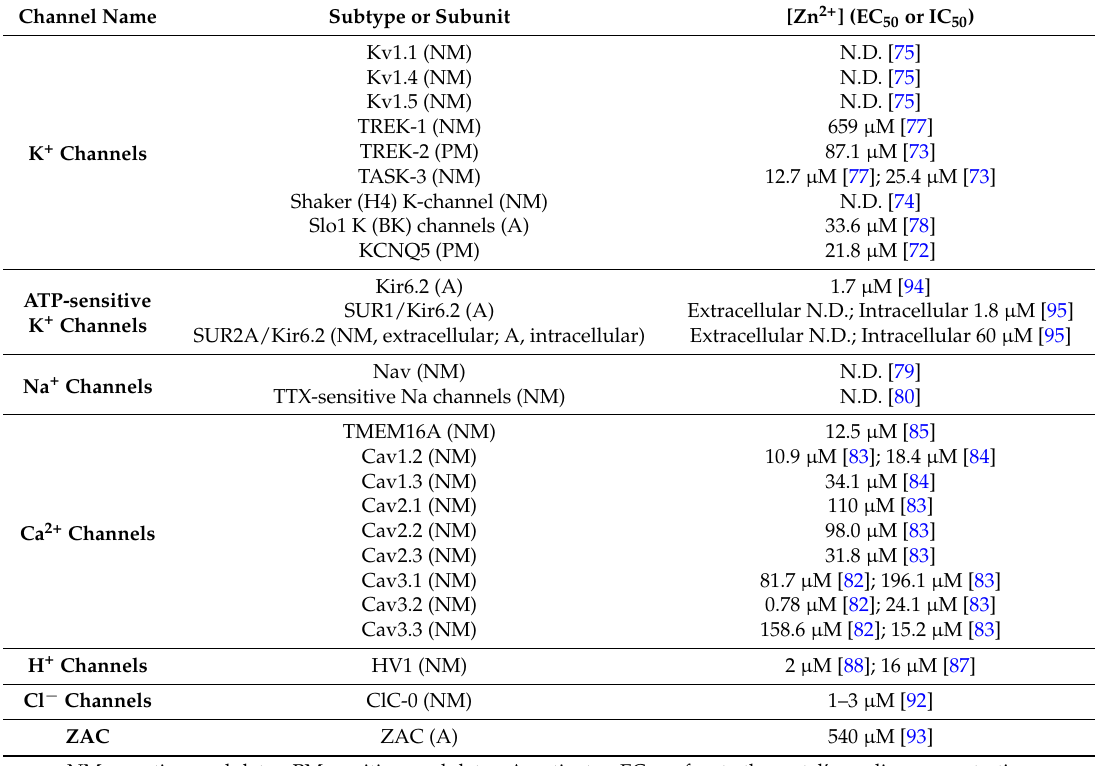
Table 3. Voltage-gated ion channels modulated by